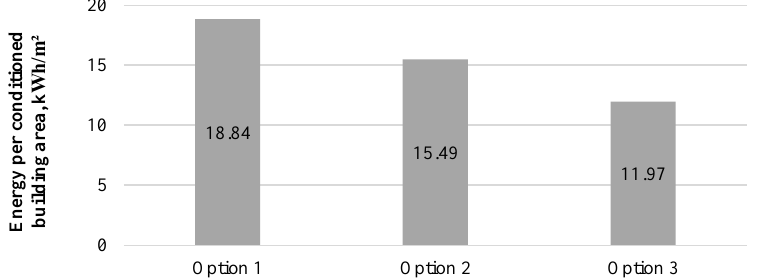
Fig. 9. Comparison of the energy use per conditioned building area between the 3 options during summer design week.